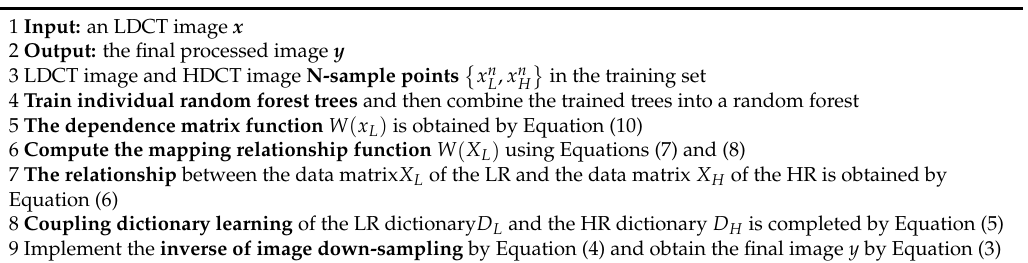
Figure 1. Flowchart of the SR algorithm. Table 1. Basic Scheme for